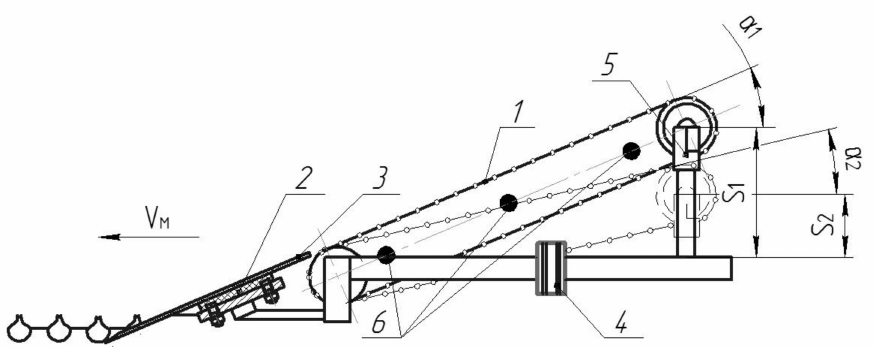
Figure 7. Diagram of changes in the angle of inclination of the rod elevator web: 1, rod eleva- tor; 2, weight sensor digging share; 3, digging coulter; 4, microcontroller; 5, electric cylinder; 6, inertial